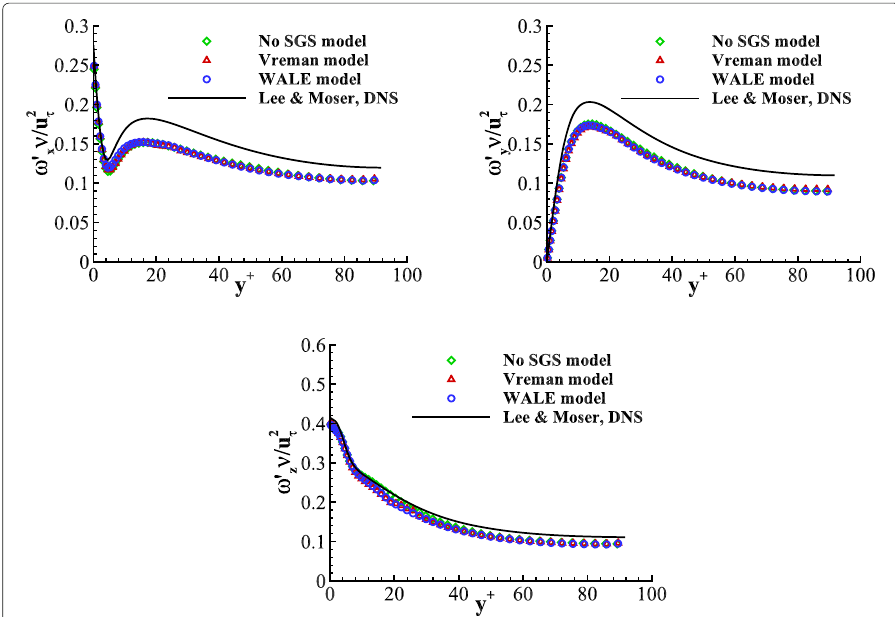
Fig. 13 The r.m.s. vorticity fluctuations for the turbulent plane Couette flow at Re τ = 93. a X component, b Y component, c Z